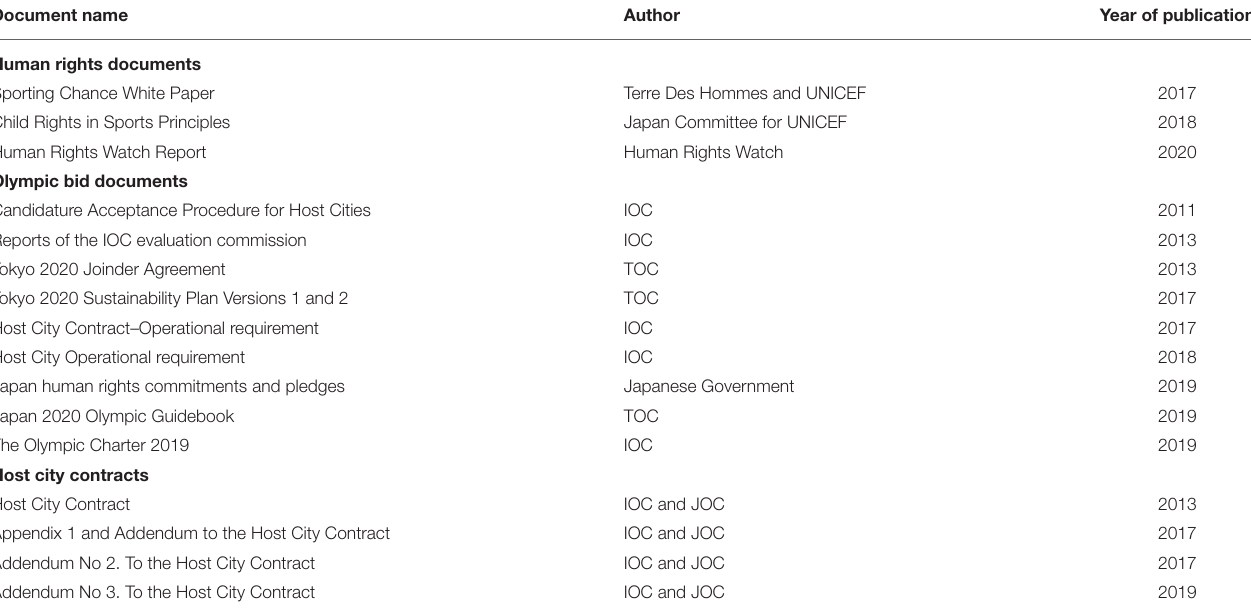
TABLE 1 | List of documents